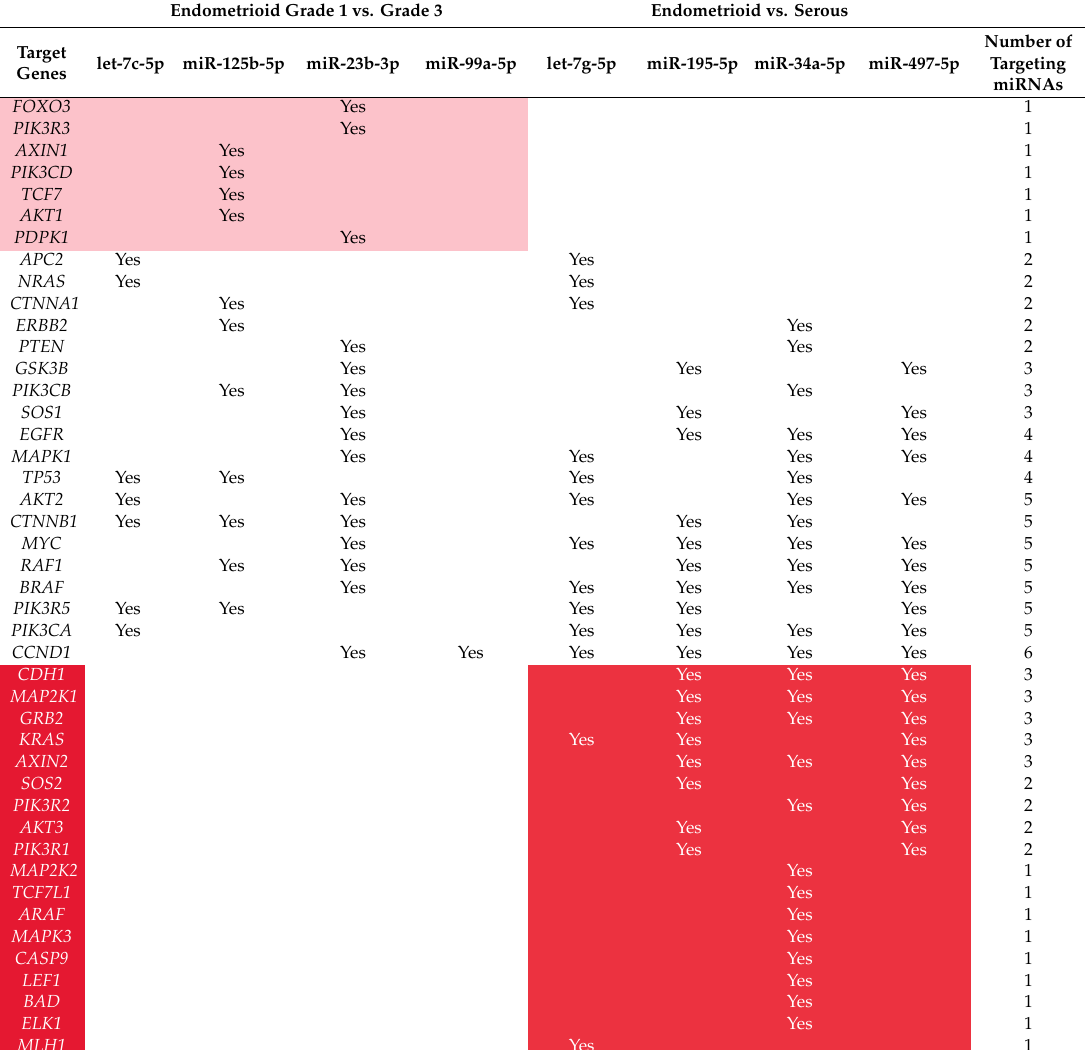
Table 3. List of 44 target genes identified by the miRPath software and divided into three distinct groups with respect to discriminating miRNAs for both comparisons of endometrial